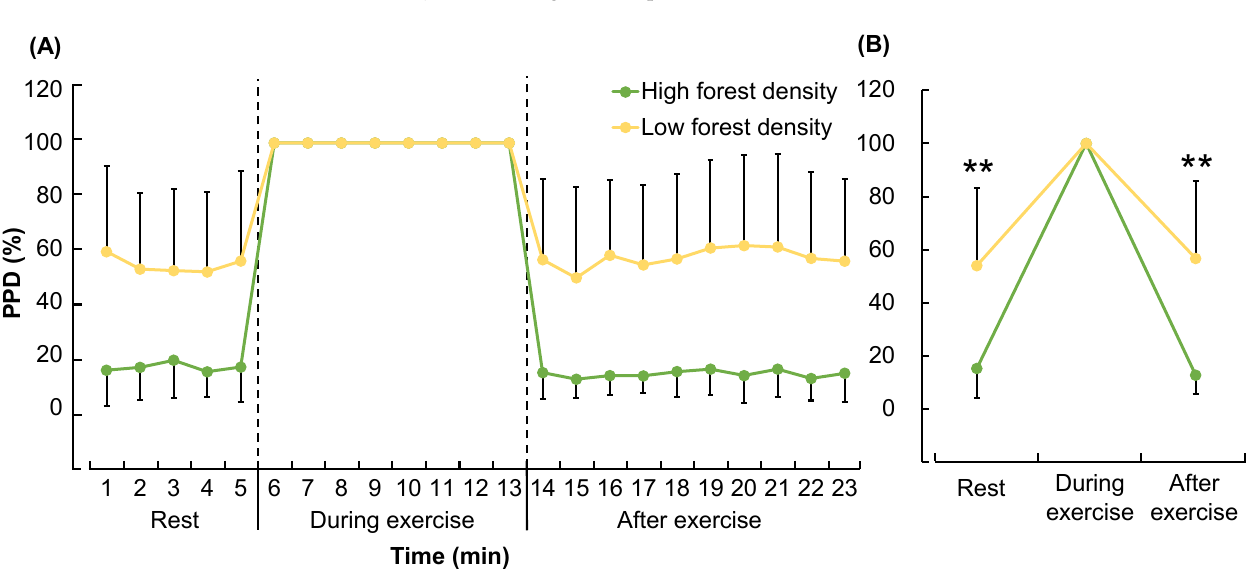
Figure 6. Changes in the predicted percentage of dissatisfied (PPD) between high forest density and low forest density. ( A ) Time ‐ dependent changes in PPD. N = 18, mean ± standard deviation. ( B ) Overall mean PPD in the “rest”, “during exercise”, and “after exercise” periods. N = 18, mean ± standard deviation; ** p < 0.01 using the independent t ‐ test.